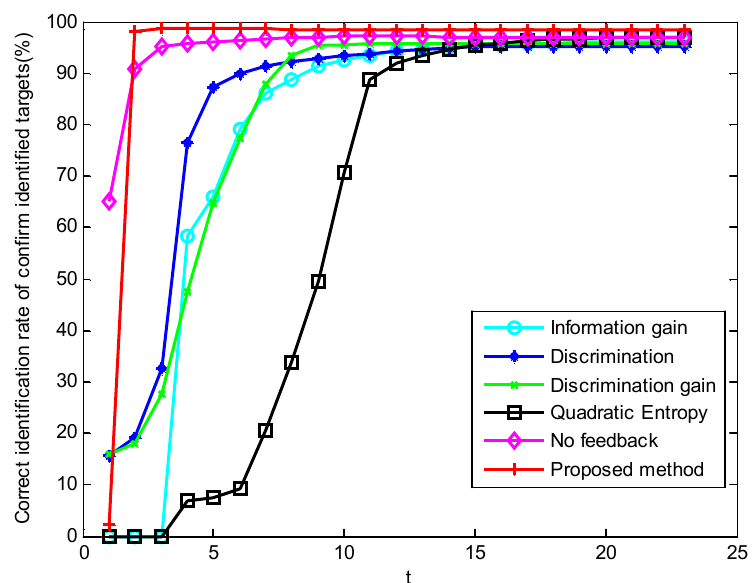
Figure 8. Sequence diagram of confirmed target recognition accuracy in scenario 5 under condition 1.